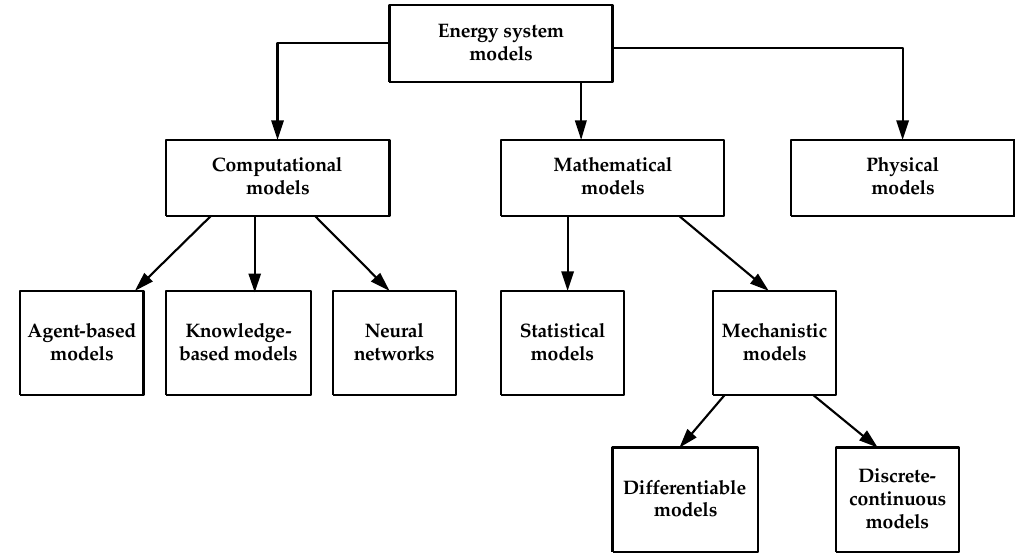
Figure 4. Classification of energy system models according to modeling approach.